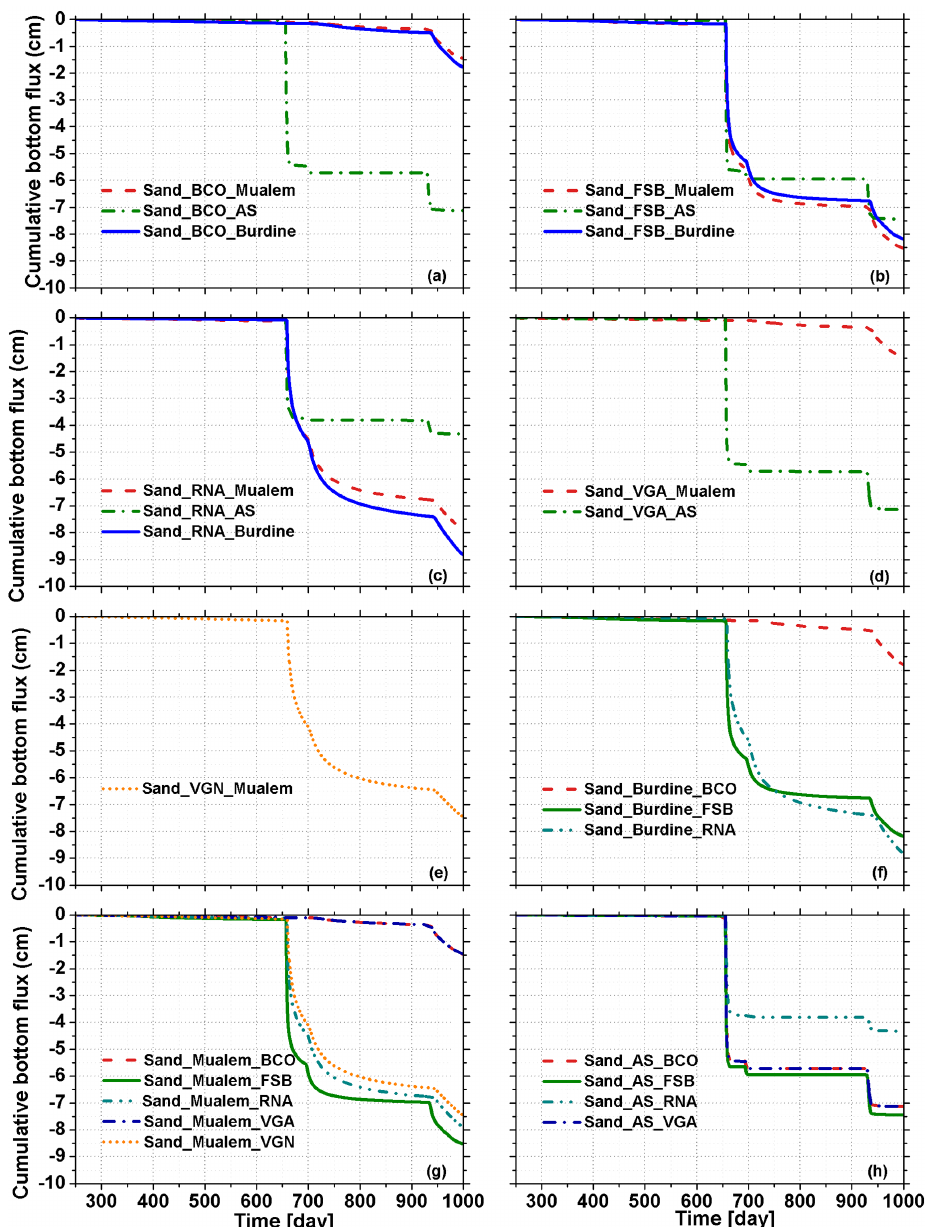
Figure 8. As in Fig. 5, but for a sandy soil column. Unlike Fig. 4, the results of Burdine’s (1953) conductivity curve are shown (f)